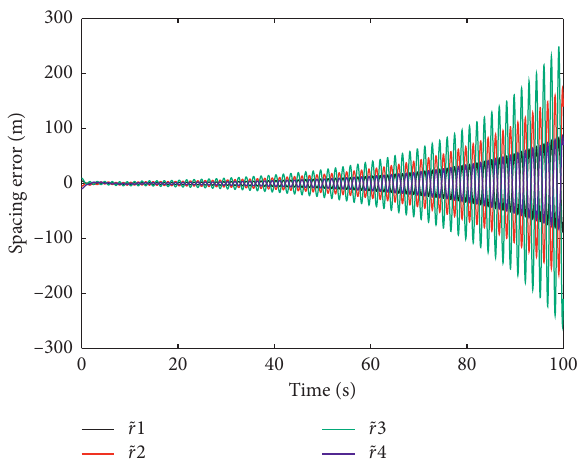
Figure 3: Spacing errors for an automated vehicular platoon under undirected topology with τ � 0 . 33 s.